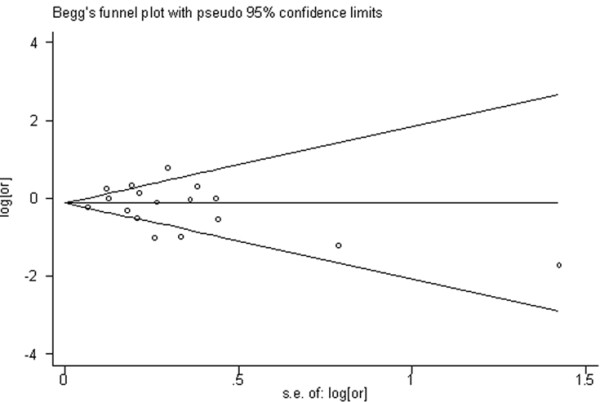
Begg's Funnel Plot of Fish Consumption and Risk of Gastric Cancer.